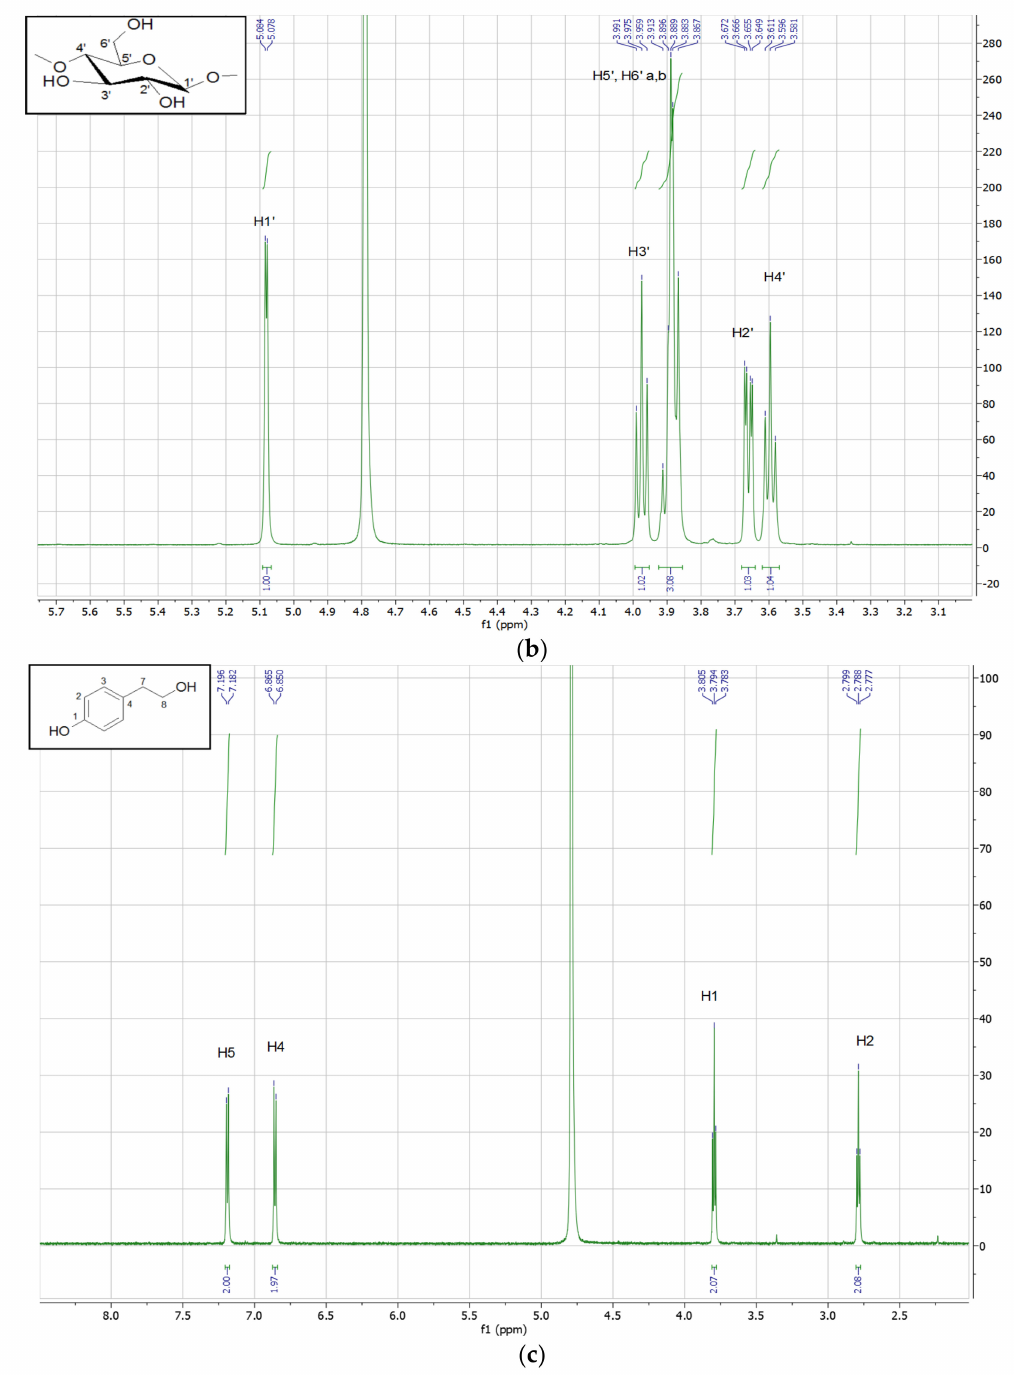
Figure 7. 1 H NMR spectrum (600MHz, D 2 O) of ( a ) TYR- β CD and expansion of the region 3.4–4.1 ppm, ( b ) β CD, and ( c ) tyrosol. The peaks of the H-3 and H-5 protons of β CD (which are located inside the cavity) present significant upfield shift ( − 0.030 and − 0.100 ppm, respectively), indicative of strong hydrophobic interactions between tyrosol and β CD inside the cavity. The upfield shift of the H-6 ( − 0.039 ppm), which lie at the primary face of the cyclodextrin cone, implies that there is also a strong interaction with tyrosol, probably between the aliphatic OH of the tyrosol molecule and the 6-OH of β CD. These results lead us to believe that the tyrosol molecule enters the cyclodextrin cone in such a way that the aromatic ring lies well inside the hydrophobic cavity whereas the aliphatic hydroxyethyl moiety points towards the primary face of the cone and strong hydrogen bonds are formed between the